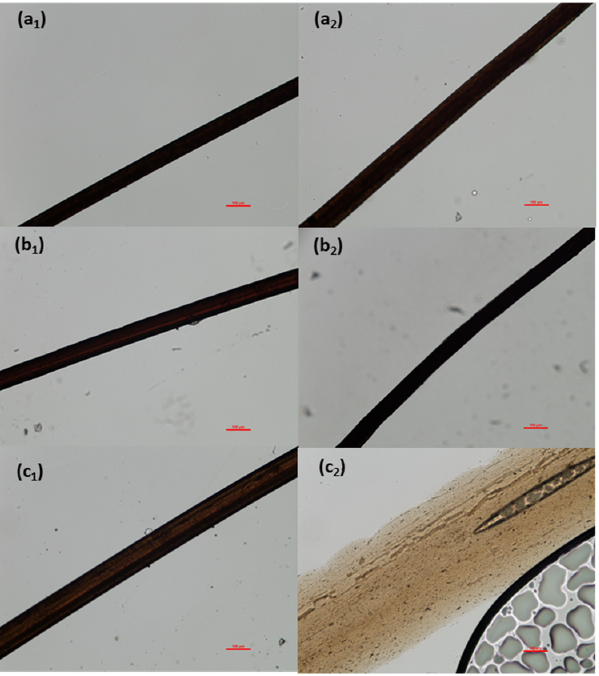
Figure 10. Optical Micrographs of ( a ) Lig3/PVA7, ( b ) Lig5/PVA5, and ( c ) Lig7/PVA3 fibers after immersion in water at (1) 25 °C and (2) 85 °C (100 µm scale bar).